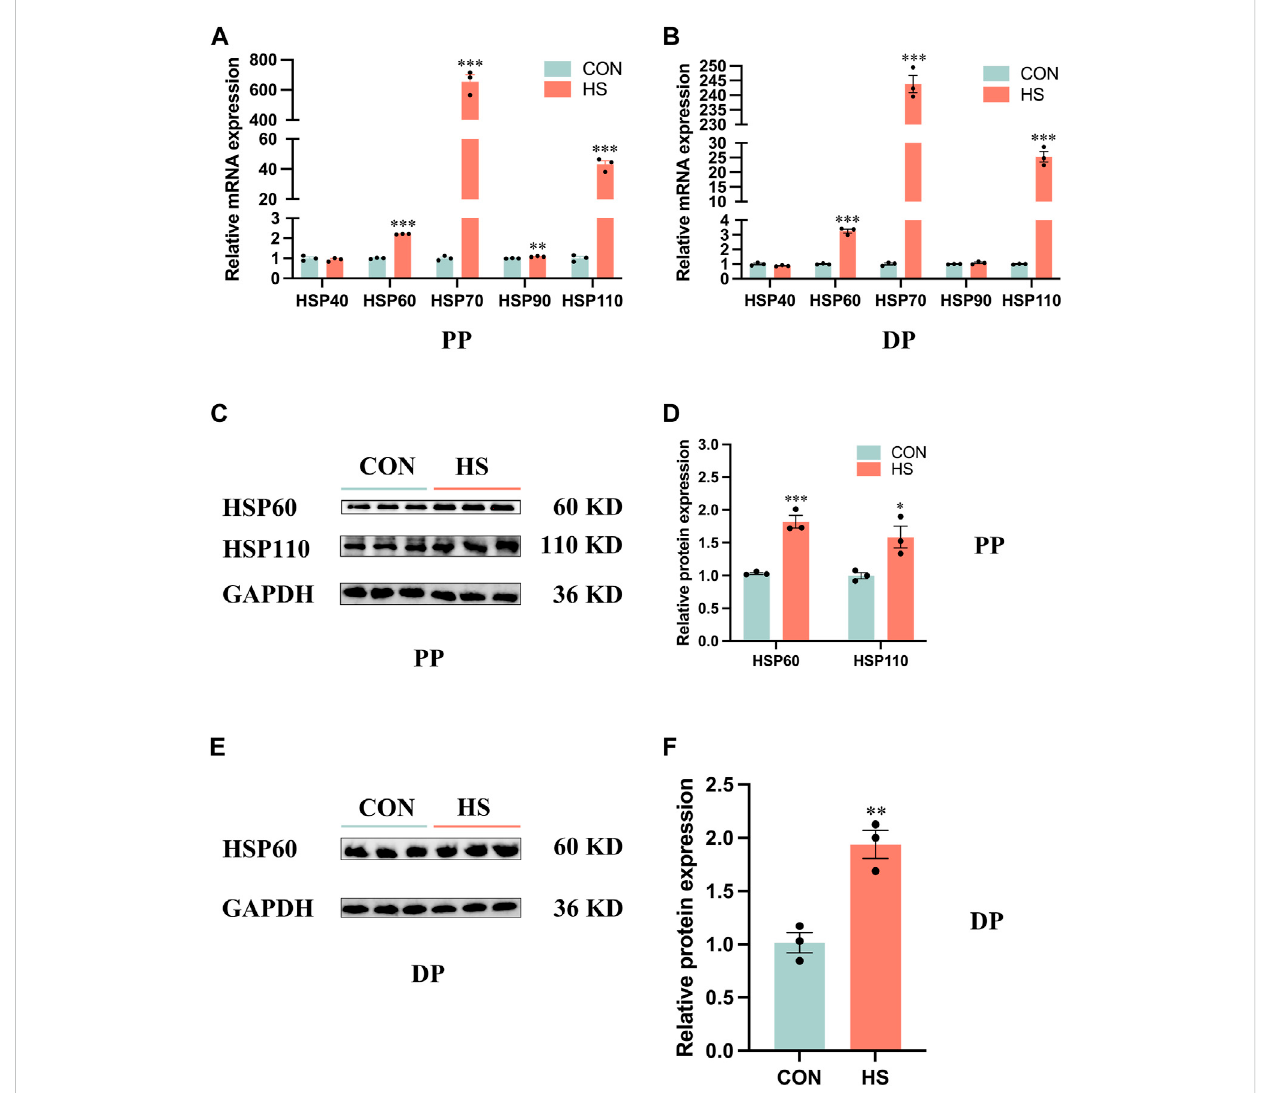
HeatstressupregulatedtheexpressionlevelsoftheHSPfamilyinmyoblasts.mRNAexpressionoftheHSPfamilyinmyoblastsduringproliferation (A) and differentiation (B) . Protein levels of the HSP family in myoblasts during proliferation (C, D) and differentiation (E, F) . All data are shown as the mean ± SEM (n = 3, * p < 0.05; ** p < 0.01, *** p < 0.01). PP: proliferation phase; DP: differentiation